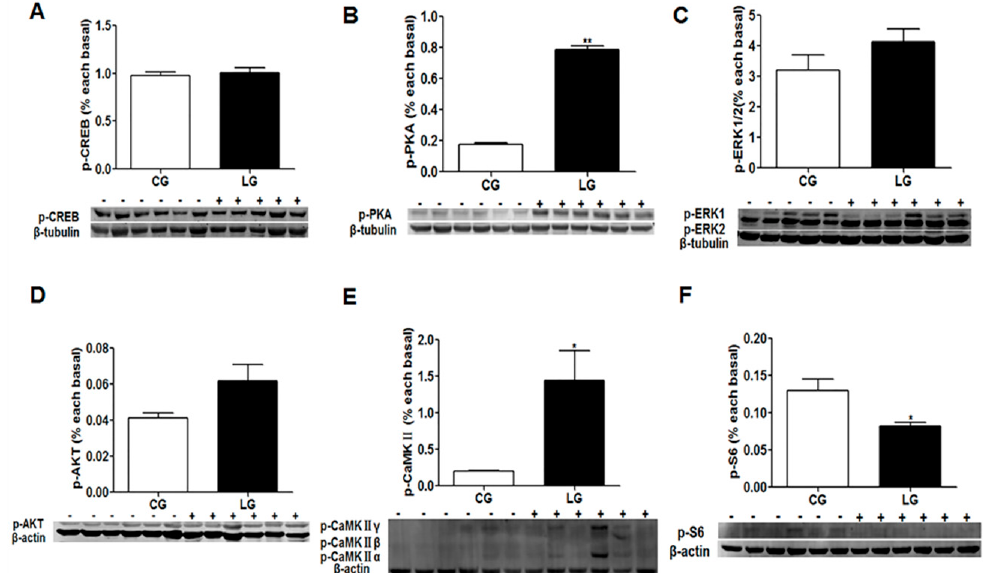
Figure 12. The phosphorylation levels of cAMP-response element binding (CREB) ( A ), protein kinase A (PKA) ( B ), extracellular regulated protein kinases (ERK)1/2 ( C ), AKT ( D ), Ca 2+ /calmodulin-dependent protein kinase II (CaMKII) ( E ) and S6 ribosomal protein (S6) ( F ) of mandarin fish (CG) with the negative demonstration fish (wild mandarin fish without training), and fish (LG) with the positive demonstration fish (well-trained fish which could accept dead prey fish). Data are represented as mean ± S.E.M. ( n = 6). A value followed by * differs significantly from all other values not followed by the same superscript at the same time point based on a one-way analysis of variance (ANOVA) followed by the post hoc test ( * p < 0.05, ** p < 0.01).